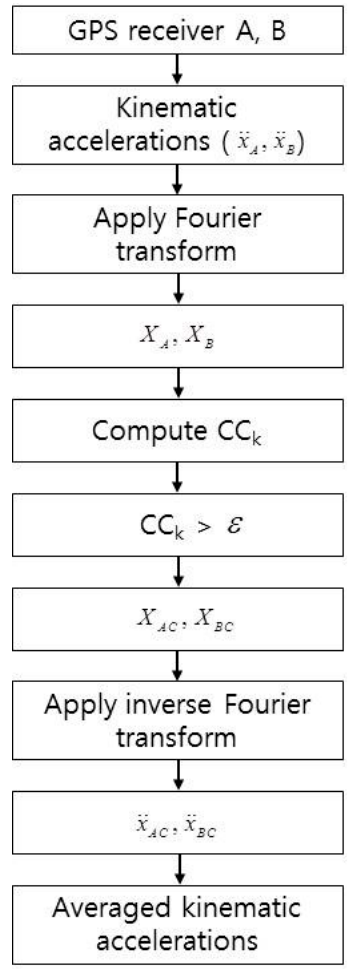
Figure 1. Flowchart of data processing.